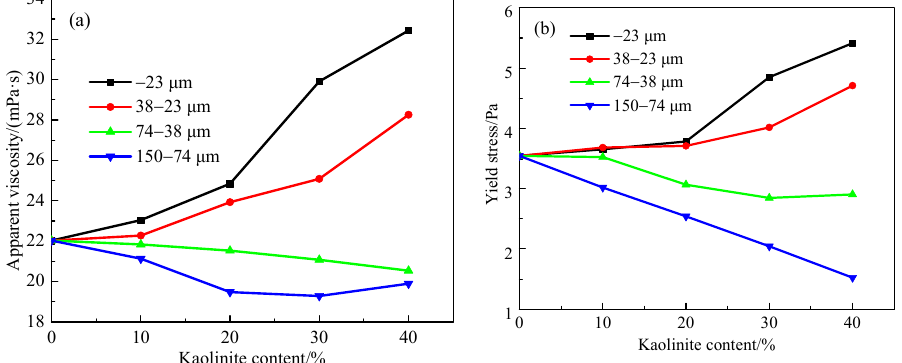
Figure 6. Effects of particle size on pulp’s ( a ) apparent viscosity and ( b ) yield stress of the mixed mineral of smithsonite- kaolinite using octadecylamine concentration: 150 mg/L at pH 9.5−10 and 28.57% solid concentration.